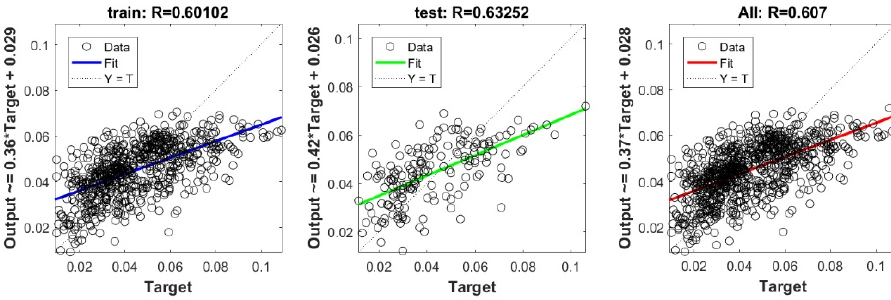
Figure A28. Scatter plots between target and output value by the PSO-Ridge model.